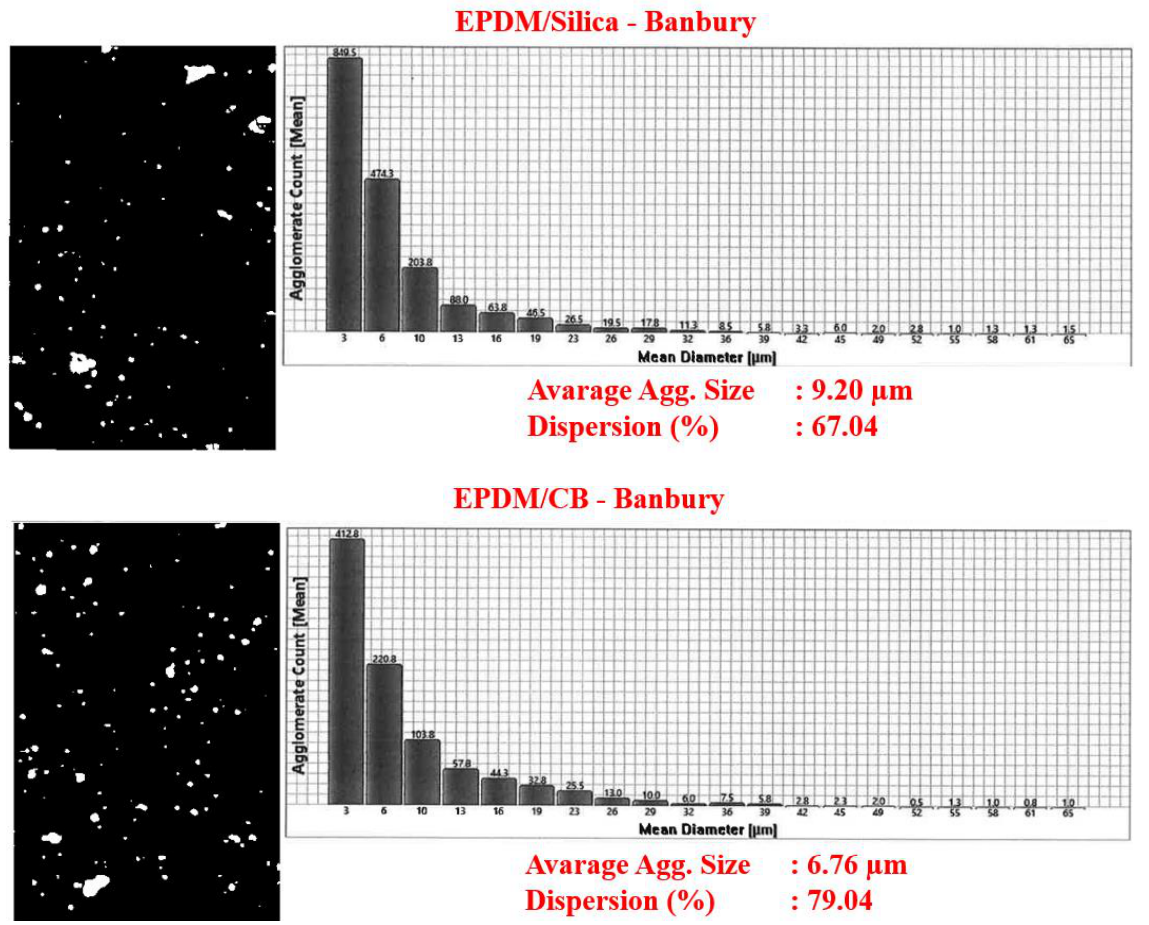
Figure 6. CB and silica dispersion in EPDM composites prepared in Banbury.